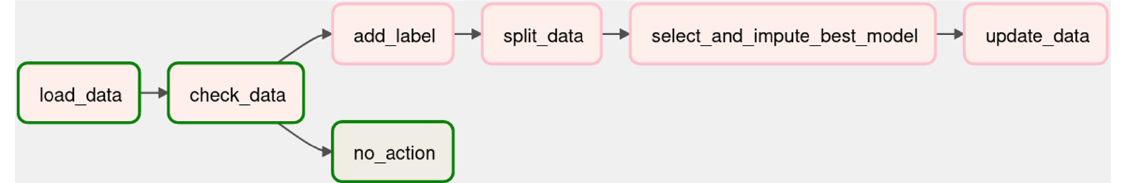
Figure 9. DAG-based workflow actions for missing data imputation utilizing AutoML libraries.